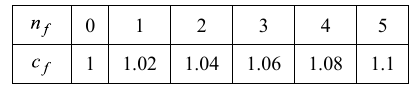
with respect to the load f